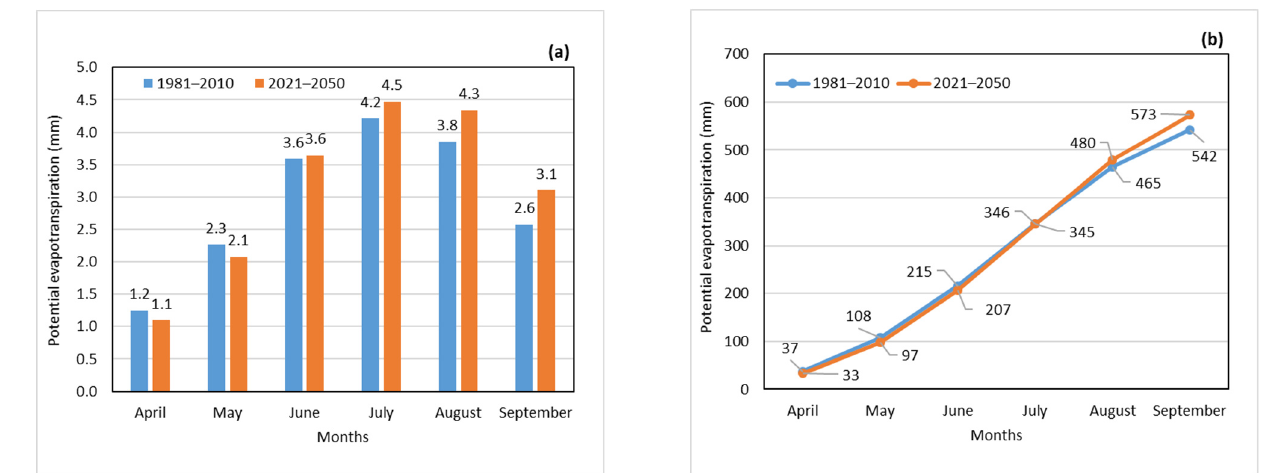
Figure 2. Sweet cherry trees' water needs (potential evapotranspiration) in the years 1981–2010 and 2021–2050 shown as average daily values ( a ) and average cumulated sum curve ( b ) during the period from April–September. Table 3. Statistical significance of the equation trends for the water needs of sweet cherry trees and their tendencies in 1981–2010 and